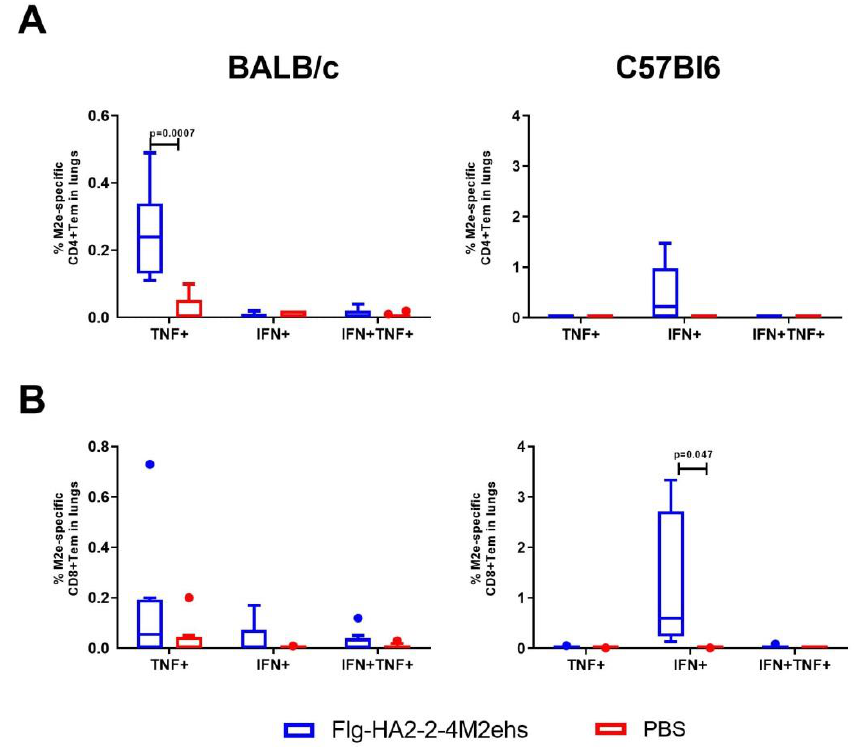
Figure 3. Cytokine profile of M2e-specific CD4+Tem ( A ), CD8+Tem ( B ) in the lungs of BALB/c and C57Bl6 mice after intranasal immunization with recombinant protein Flg-HA2-2-4M2ehs. The data are presented as Tukey plots. The data of two experiments ( n = 8) were summarized. Significant differences from the control are shown.